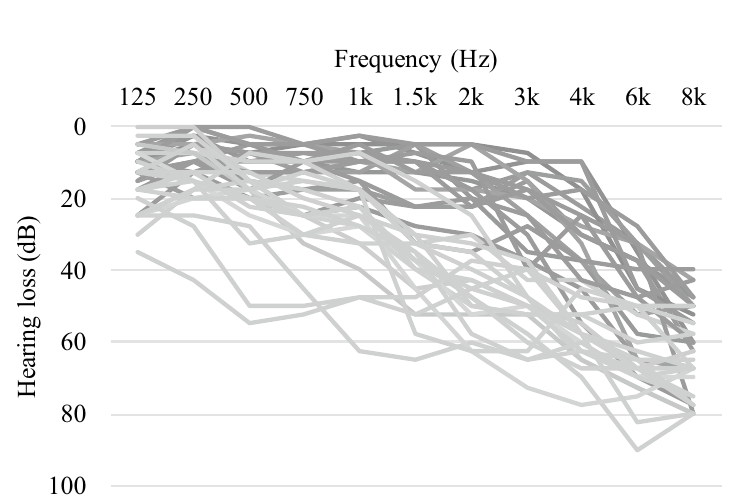
Figure 1. Pure tone audiograms. Average pure tone audiograms for all subjects averaged over both ears (hearing aid users in light grey, non-hearing aid users in dark